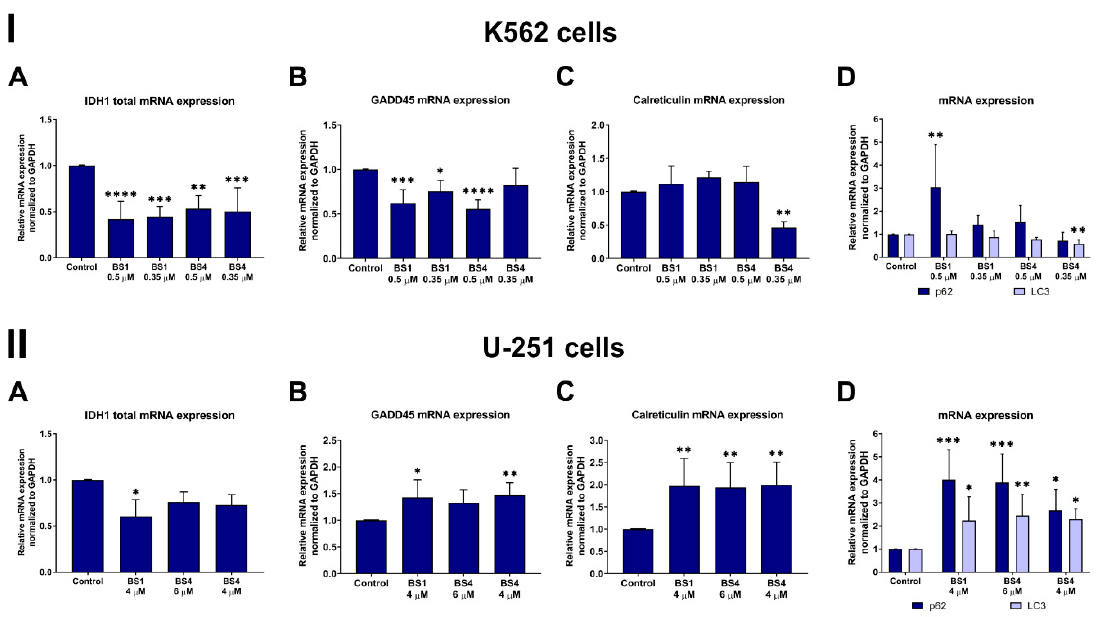
Figure 7. mRNA expression of selected genes, IDH1 ( A ), GADD45 ( B ), calreticulin ( C ), p62 and LC3 ( D ), in the K562 ( I ) and U-251 ( II ) cells after incubation with tested compounds ( BS1 , BS4 ) at various concentrations. Data are shown as the mean ± SD of several independent measurements. The statistical analysis was performed using a two- ( A , D ) or one-way ANOVA ( B , C ) with Bonferroni’s post-hoc test: * p < 0.05, ** p < 0.01, *** p < 0.001, **** p < 0.0001 compared to the untreated cells (control).